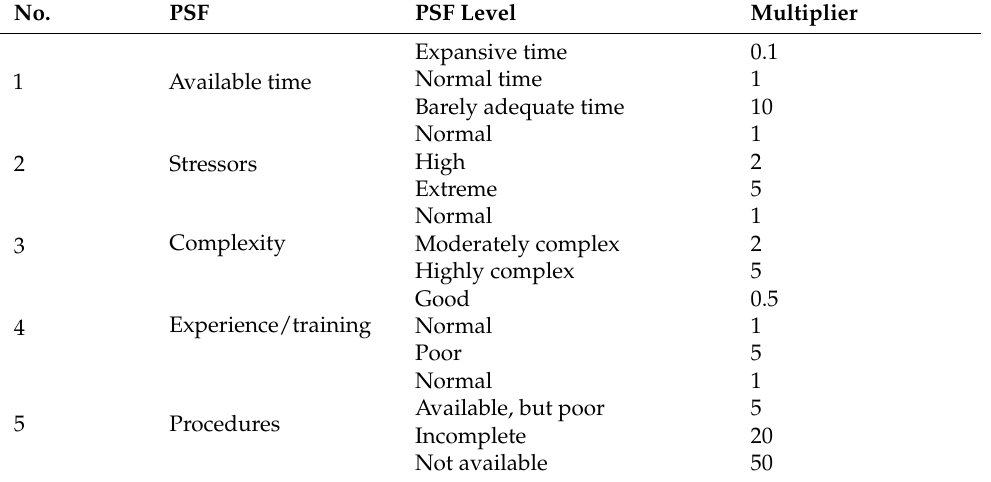
Table 1. SPAR-H PSFs, levels, and